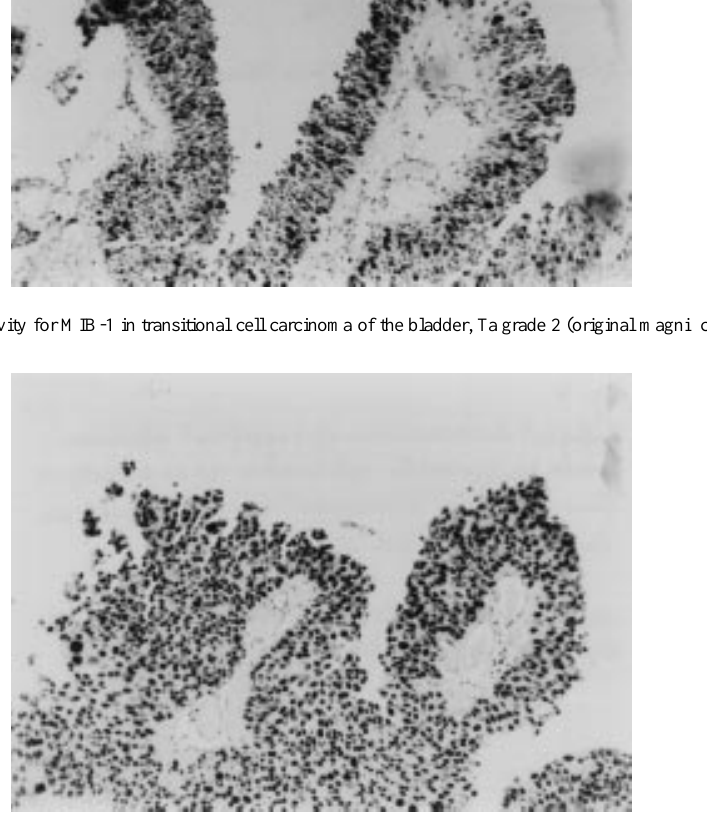
Fig. 4. Expression of p53 in a transitional cell carcinoma of the bladder, Tis, grade 3 (original magnification (cid:2) 250). Immunoreactivity is present in most of the neoplastic cells.